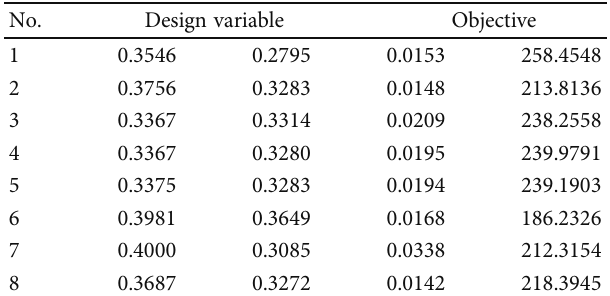
Table 1: Interpolation